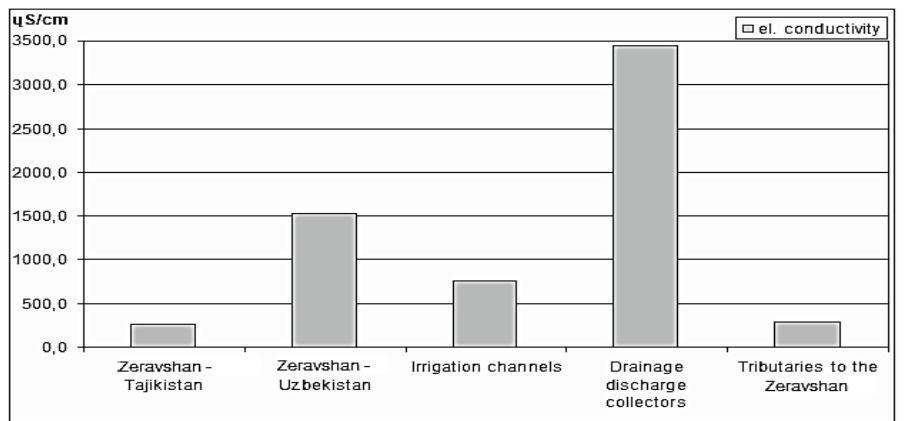
Fig. 2 Electrical conductivity of Zeravshan River in Tajikistan and Uzbekistan territories, irrigation channels and drainage collectors in Uzbekistan and tributaries of Zeravshan River.